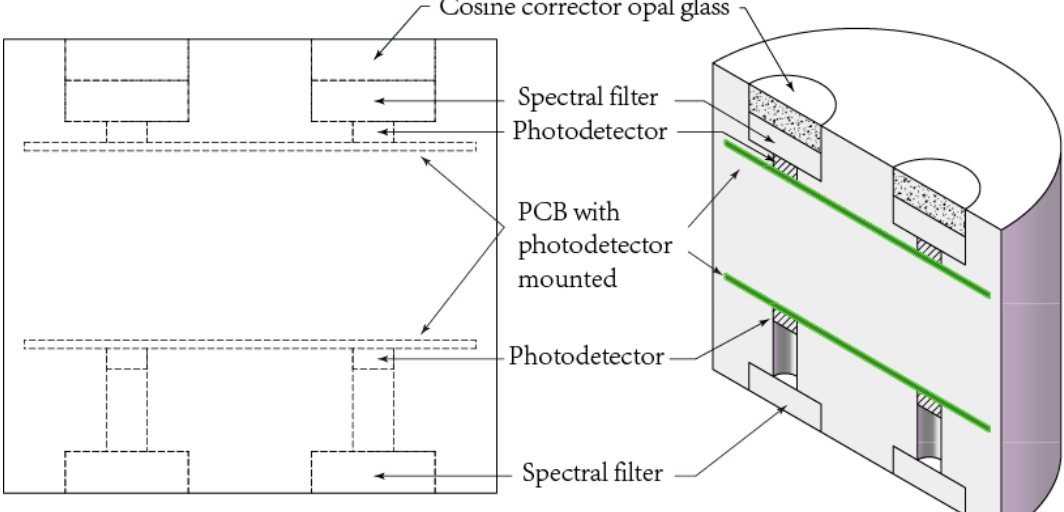
Figure 4. Schematic of the optical sensing unit.